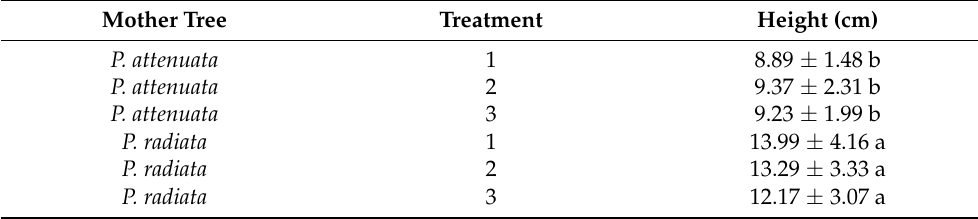
Table 5. Height of somatic plants (cm) from embryogenic cell lines in which P. attenuata or P. radiata var. cedrosensis acted as the mother and from different initiation treatments (1, 2 and 3) after six months in the